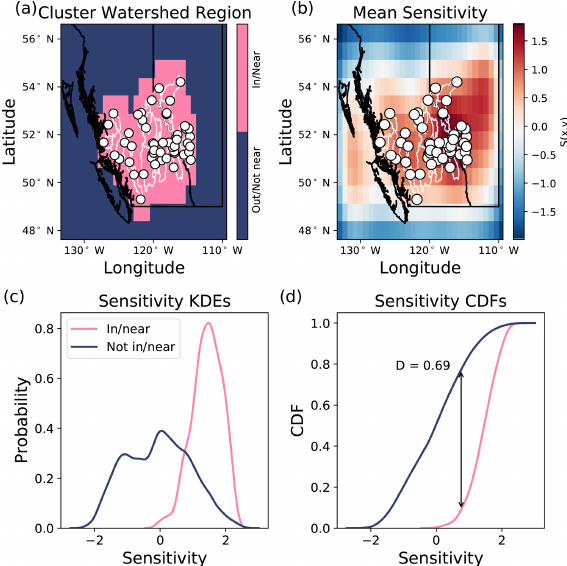
Figure A6. Steps of calculating the D statistic from the Kolmogorov–Smirnov test. (a) The mask of pixels which are either within/near the cluster watersheds (pink) or are outside/far from the watershed boundaries (blue). (b) The mean sensitivity evaluated over the test period for the ensemble of models is shown, with red indicating more sensitive and blue indicating less sensitive. (c) The sensitivity distributions (within/near in pink and not within/near in blue), calculated by kernel density estimation (KDE), using Gaussian kernels and Scott’s rule for kernel bandwidth calculation. (d) The Kolmogorov–Smirnov D statistic is calculated from the sensitivity cumulative density functions (CDFs).